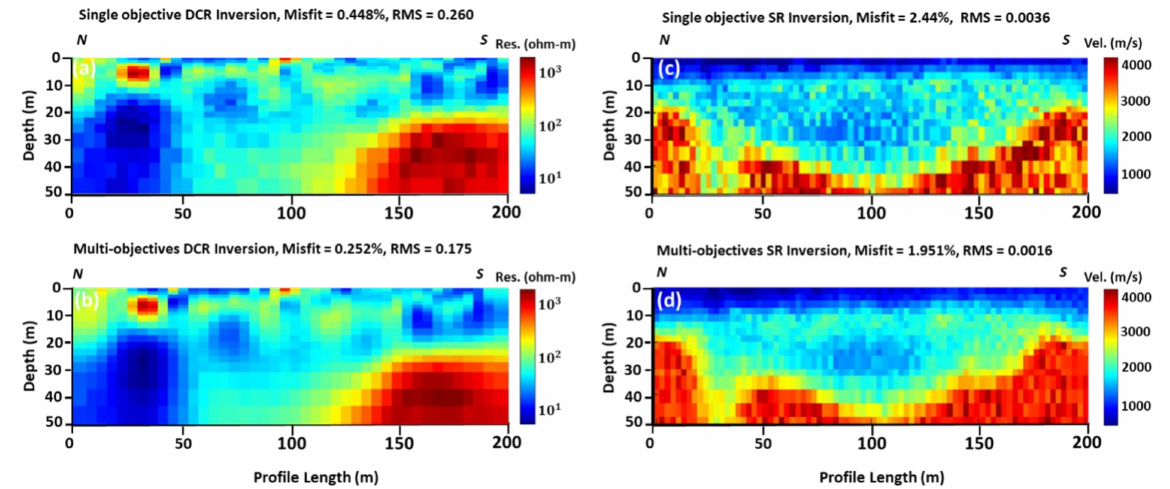
Figure 5. DCR and SR inversion using global optimization method: ( a ) single objective inverted resistivity model; ( b ) multi-objectives inverted resistivity model; ( c ) single objective inverted velocity model; and ( d ) multi-objective inverted velocity model. All geophysical models are vertically exaggerated by